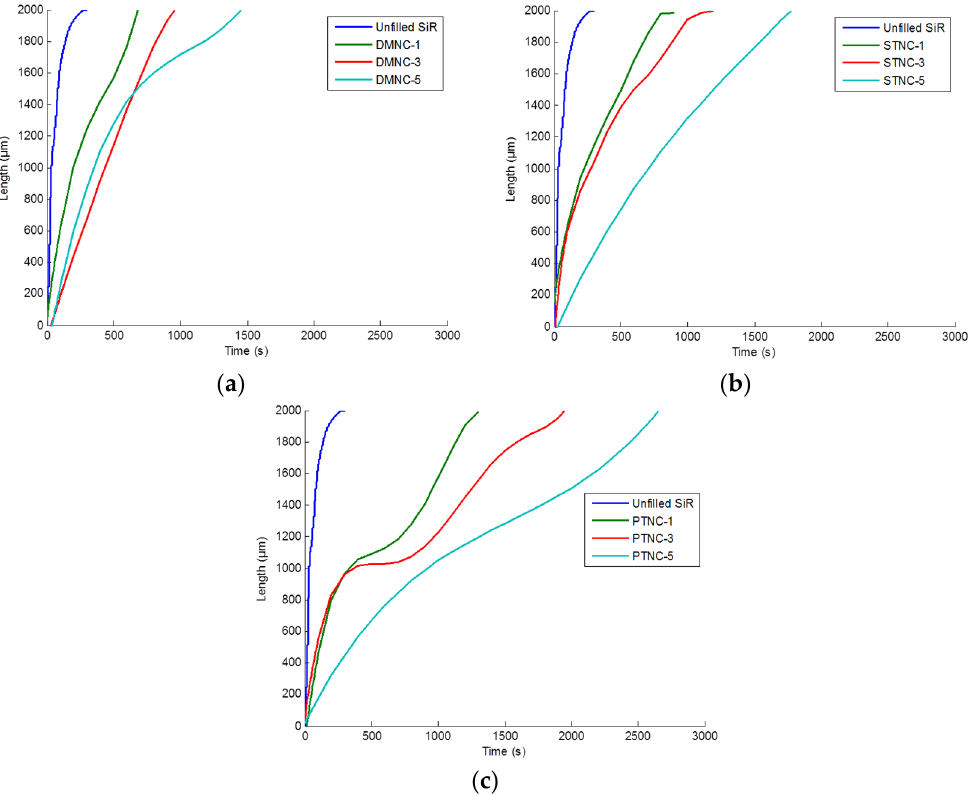
Figure 7. Electrical tree performance ( a ) DMNC; ( b ) STNC; ( c ) PTNC.